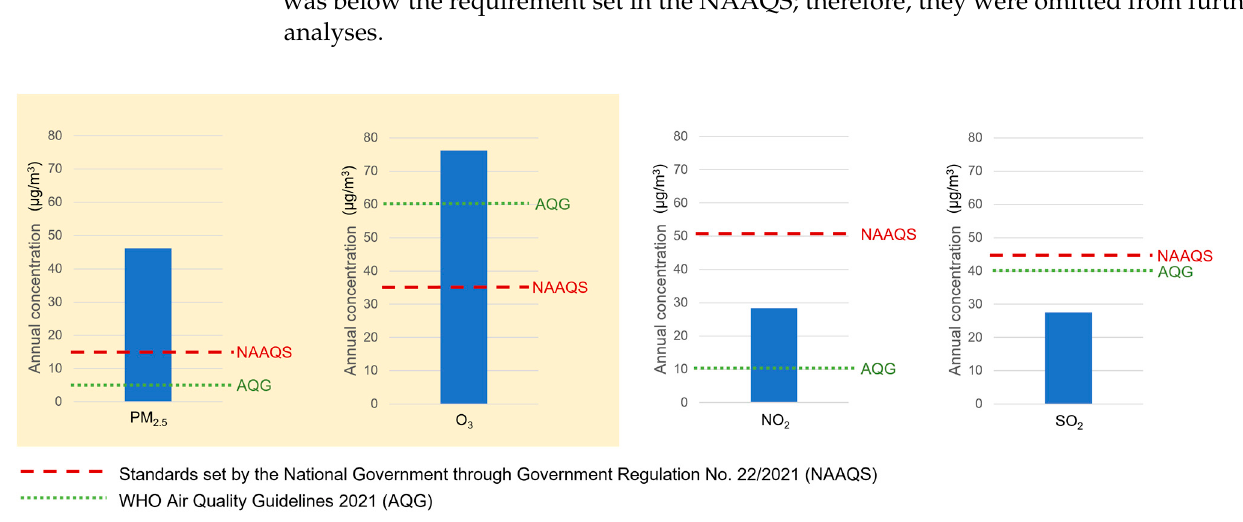
Table 4. Demographic characteristics of Jakarta Province and the five cities.